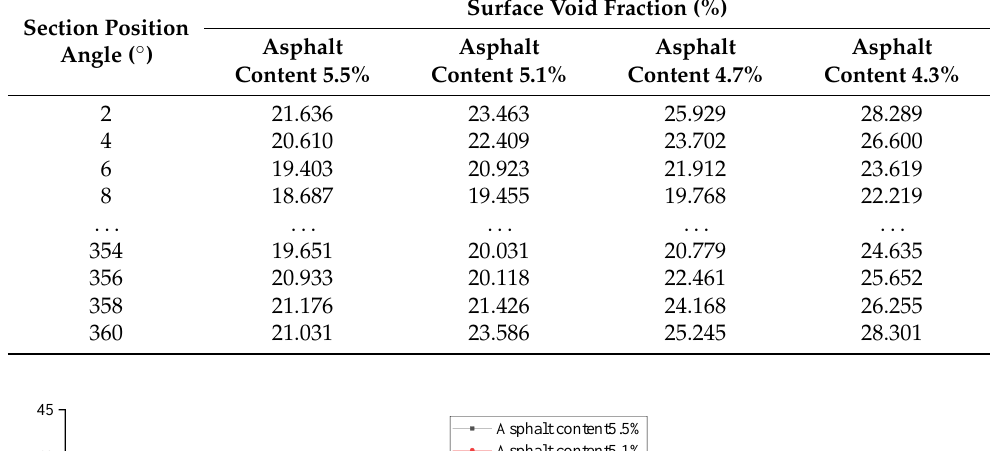
Table 6. EPA-13 surface voids at different radial section positions.